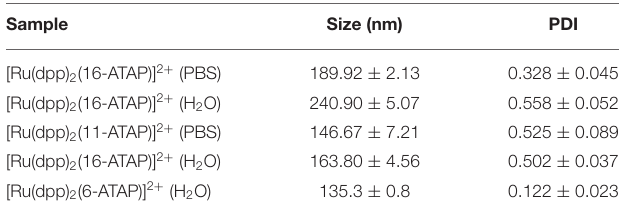
TABLE 2 | DLS and Zeta potential measurements of [Ru(dpp) 2 (16-ATAP)] 2 + (5 µ M) and [Ru(dpp) 2 (16-ATAP)] 2 + (5 µ M) in H 2 O and PBS buffer (pH 7.4).